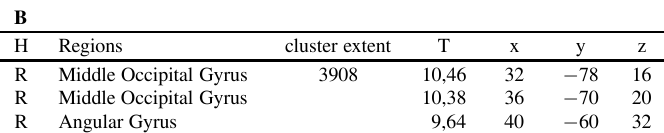
Middle Occipital